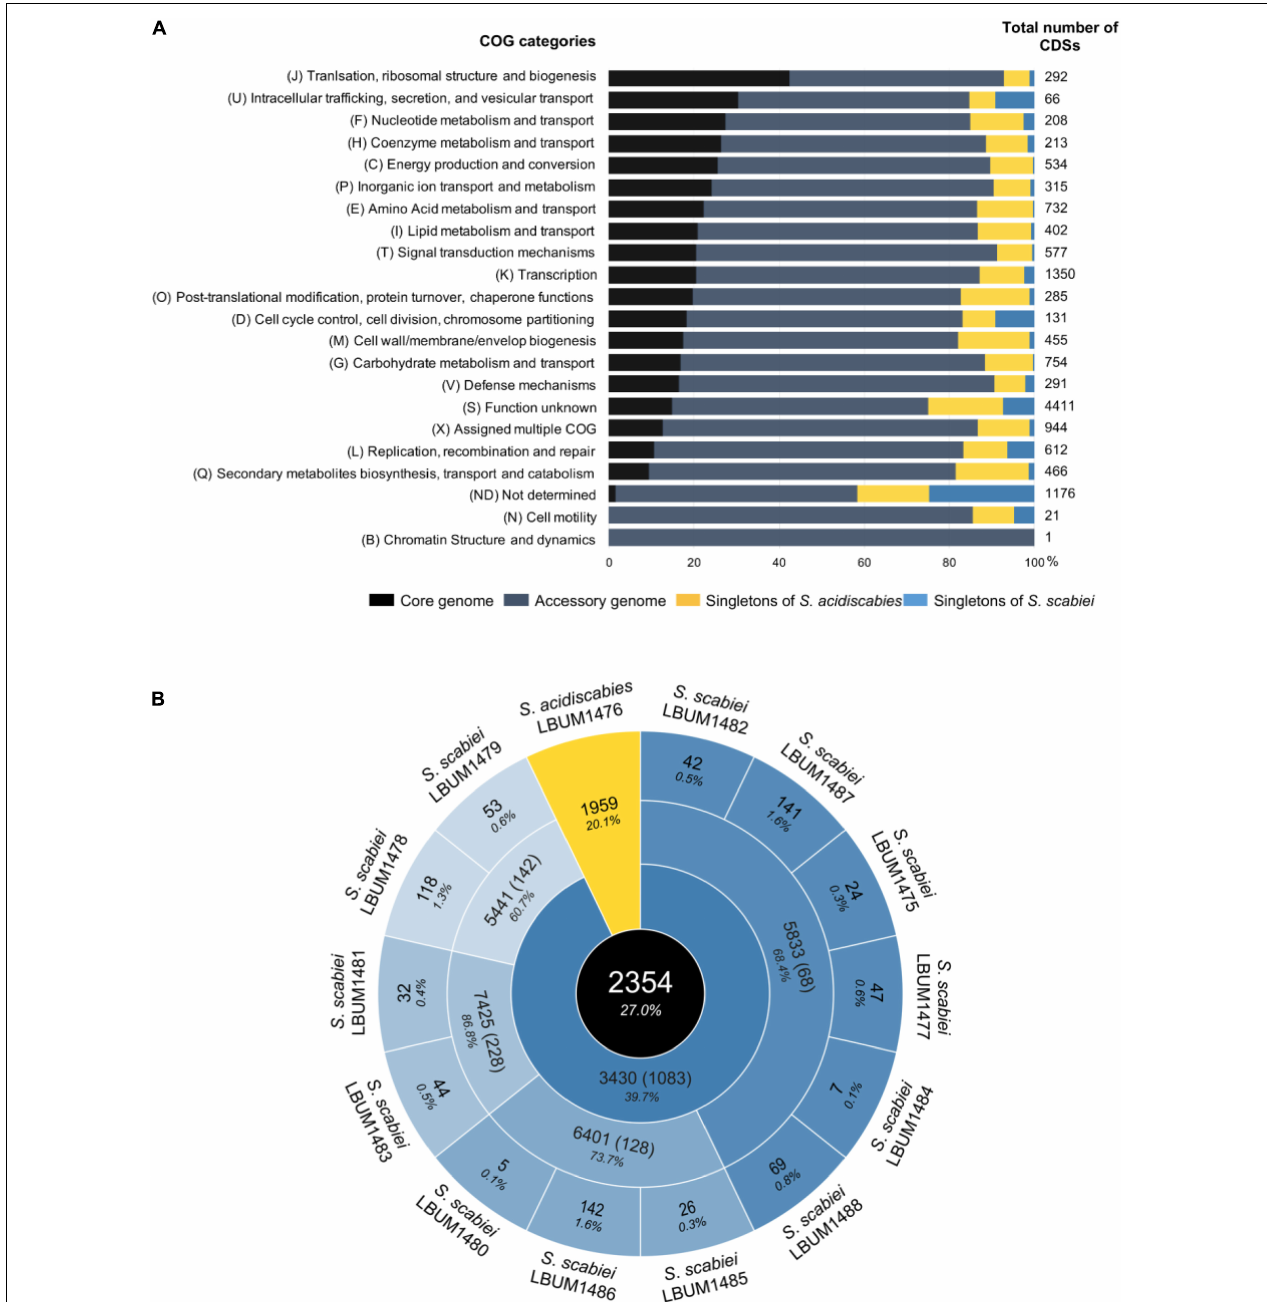
FIGURE 2 | Distribution of the orthologous CDSs from the pan-genome of the 14 scab-causing Streptomyces strains under study based on the COG categories (A) and their numbers belonging to the core-genome, group-specific, and strain specific genomes (B) . In the histogram, bars are sorted by the proportion of CDS associated with the core-genome, the accessory genome and singletons (in S. acidiscabies and S. scabiei ) in each functional category (A) . The numbers presented in the circles from inside to outside: The black circle shows the core-genome of the 14 strains used in this study. The second circle shows the core-genome of each species – i.e., the 13 S. scabies (blue) and the only S. acidiscabies (yellow). The third circle compares the different Streptomyces scabiei core-genomes. Finally, the fourth and outermost circle represents the singletons (i.e., the CDSs that are strain-specific). The numbers in brackets indicate the number of CDSs that are species or group-specific (i.e., CDSs present in every strains from a species or a group but absent in all other strains). The percentages indicate the proportion of core genes (or singletons) compared to the average number of CDSs in the relevant set of strains (e.g., the core-genome of 2302 CDSs found for the 14 strains from Streptomyces represent, in average, 26.4% of the total number of CDSs for each strain from this set) (B) .